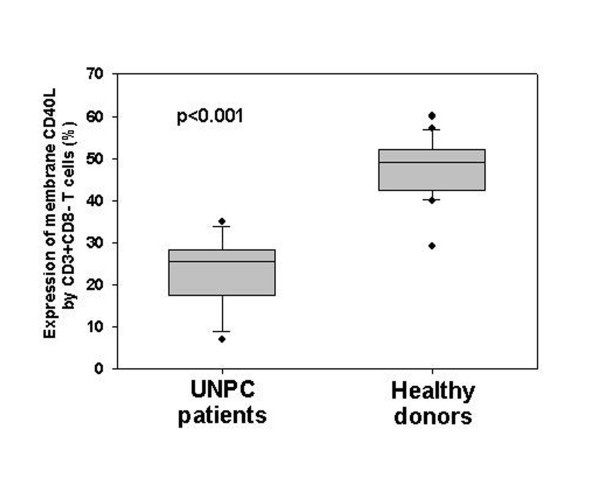
Membrane CD40L expression by stimulated CD3+CD8- circulating T lymphocytes in UNPC patients and healthy donors. The analysis was carried out using a two-color flow cytometric assay coupled with a previously described gating strategy [42]. The percentage of stimulated CD3+CD8- expressing membrane CD40L is indicated on the y axis. A significantly lower percentage of CD3+CD8- T cells from UNPC patients up-regulated CD40L upon stimulation as compared to controls (p < 0.001). The difference remained statistically significant also after correction for the number of CD4+ cells.